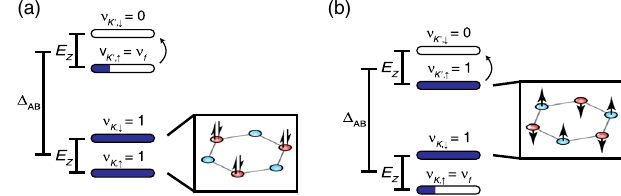
FIG. 7. Schematic of the isospin phase transition. (a) Single particle energy level diagram for the zero Landau level in the low magnetic field regime. The K valley is fully occupied, corre- sponding to a sublattice polarized state (inset). Additional frac- tional occupation is in the K 0 ; ↑ level. Spin-1 excitations with E ð q ¼ 0 Þ ¼ E consist of excitations between the partially filled Z and empty K 0 states, indicated by the arrow. (b) The same diagram but for the high-field phase. Now the underlying order is antiferromagnetic (inset). Spin-1 excitations from the fractionally occupied level are Pauli blocked, with low-energy excitations possible only between the filled K 0 ; ↑ and empty K 0 ; ↓ levels — identical to those of the quantum Hall ferromagnets in the injector and